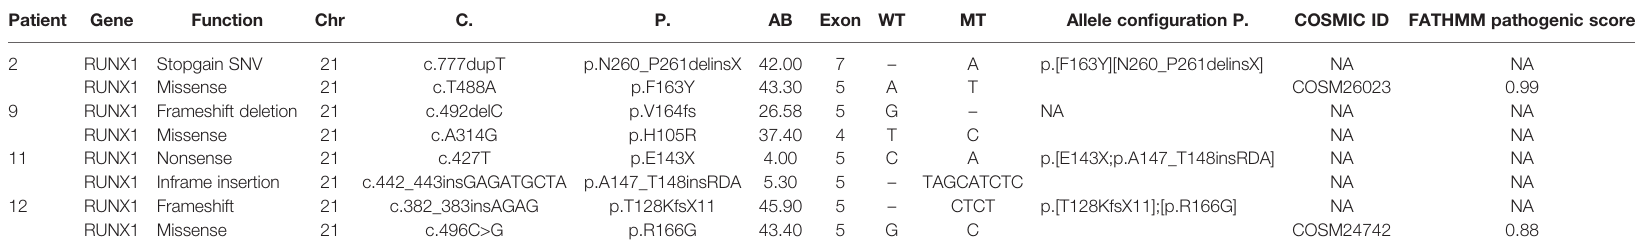
TABLE 3 | Pattern of RUNX1 mutations in three AUL patients and one MPAL B/myeloid.